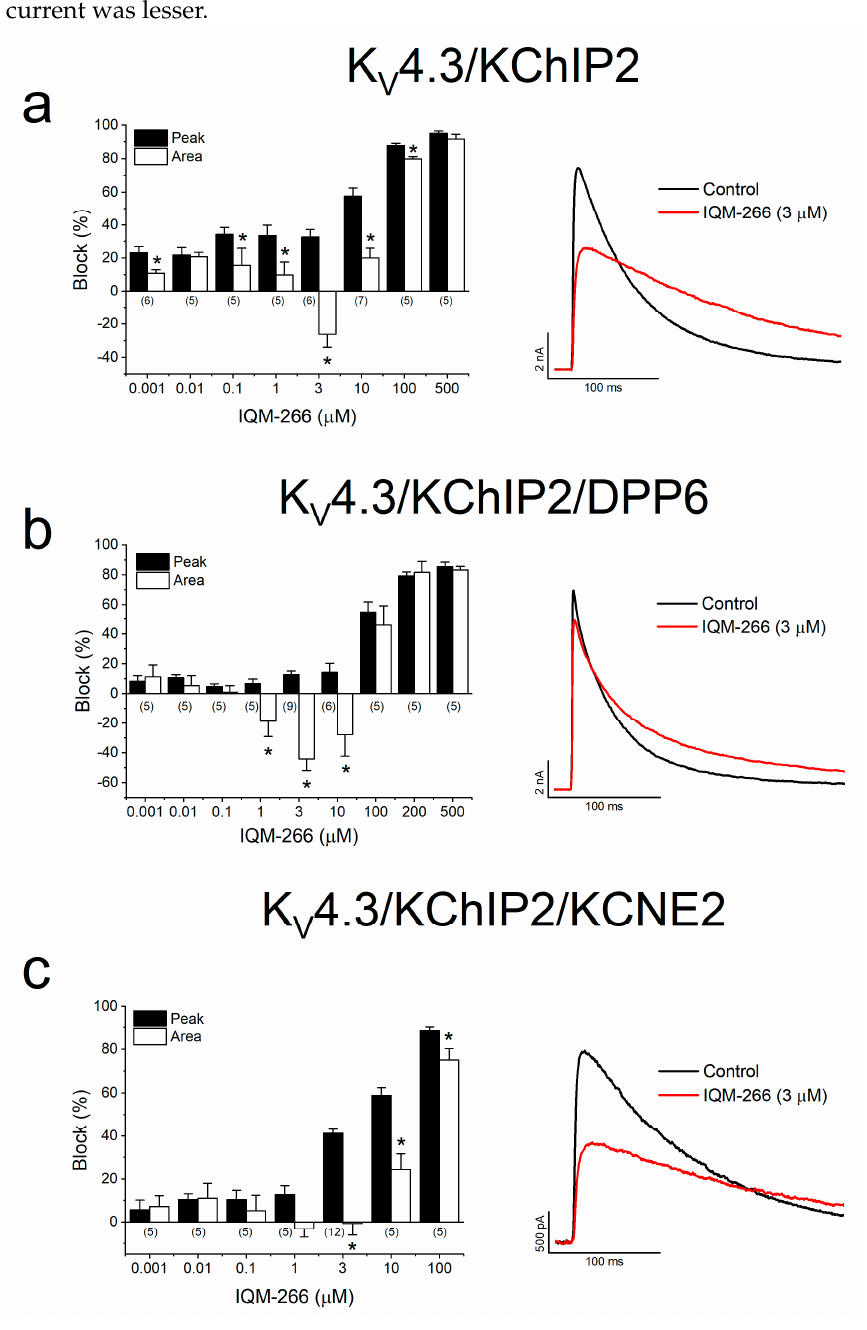
Figure 2. Concentration-dependent interaction between IQM-266 K V 4.3/KChIP2, K V 4.3/KChIP2/DPP6 and K V 4.3/KChIP2/KCNE2. ( a – c ) Inhibition or increase of the current induced by IQM-266 in K V 4.3/KChIP2 ( a ), K V 4.3/KChIP2/DPP6 ( b ) and K V 4.3/KChIP2/KCNE2 ( c ) channels measured at the maximum peak current and in the charge (measured as the area of the current during the application of a 250 ms pulse to +60 mV). Right panels show current records obtained in the absence and in the presence of IQM-266 (3 µ M). Each bar represents the mean ± S.E.M. of the number of cells shown in the bars. Statics was performed by a paired Student t-test comparing the block produced at the peak current and the block/increase produced at the charge for each concentration of IQM-266 tested. *: p < 0.05.